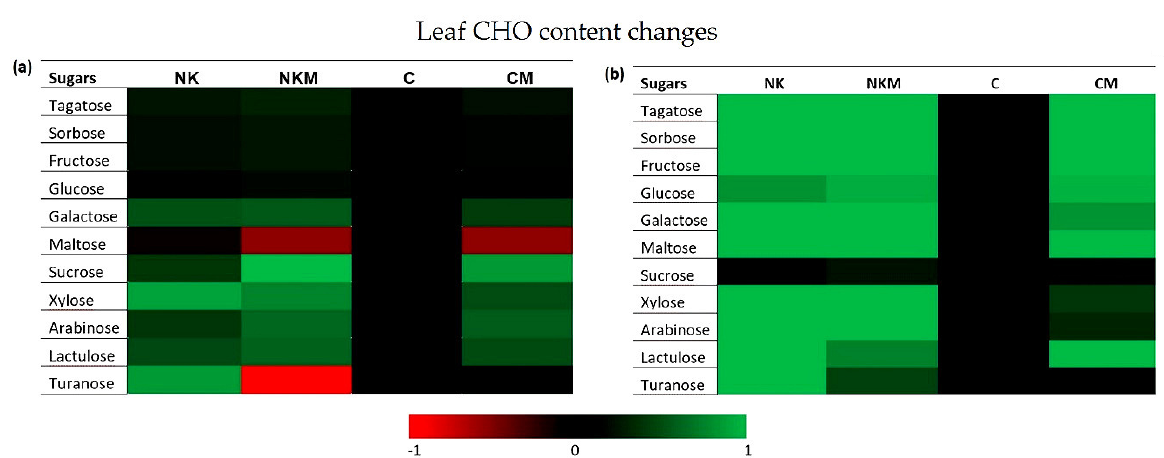
Figure 2. ( a - c ) Mean values (±SE) of leaf monosaccharide ( a ), disaccharide ( b ) and total sugar ( c ) content, as recorded in July, October and February samplings of all treatment groups (NK: KNO 3 fertilizer; NKM: KNO 3 in combination with PGPR; C (Control): NH 4 NO 3 fertilizer and CM: NH 4 NO 3 fertilizer in combination with PGPR). “Sampling”, “Treatment” and “Sampling × Treatment” on the top of the graphs indicate a significant effect of the sampling period, the treatment or their interactive effect, respectively, as revealed by ANOVA (*** p < 0.001). Different superscript letters denote significant differences between treatments (a: corresponds to the lowest value).